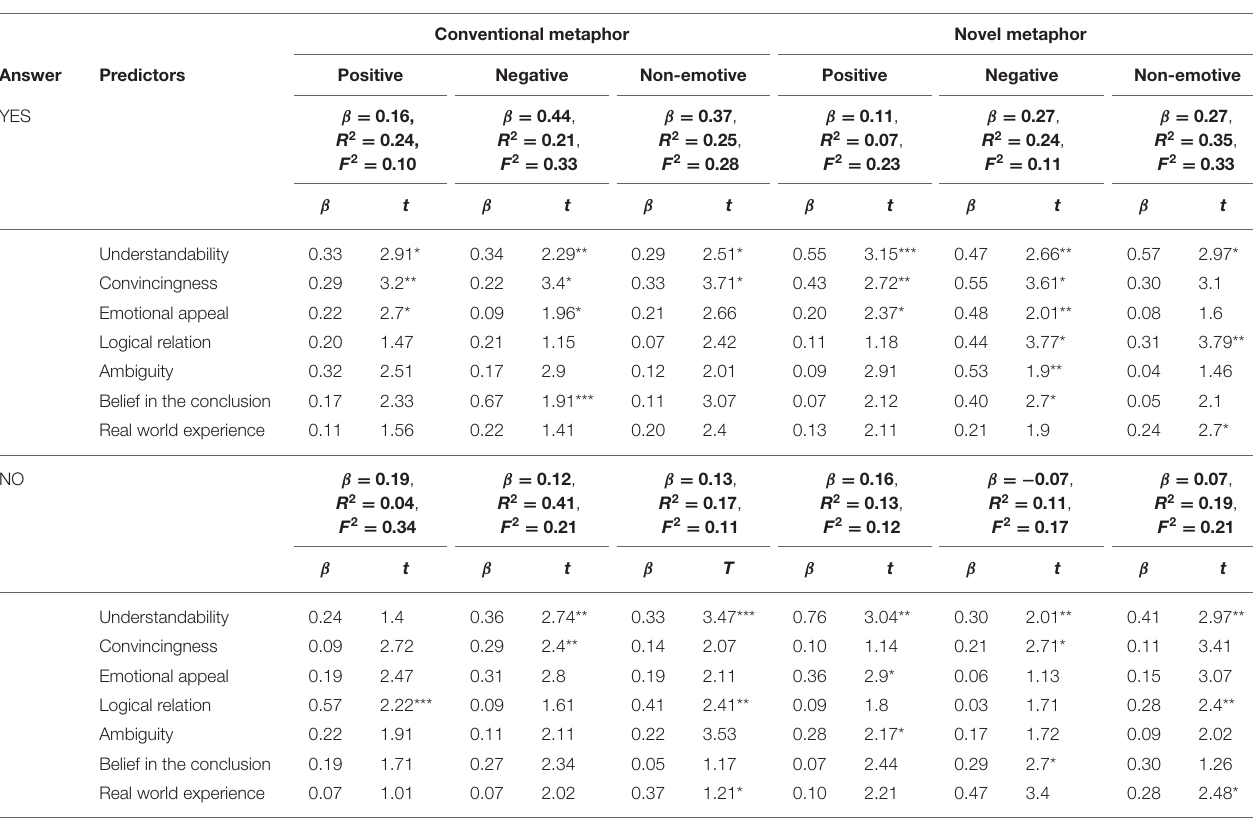
TABLE 11 | t/p -values for each predictor in the evaluation of arguments, comparing the middle term conditions (Experiment 2). Conventional